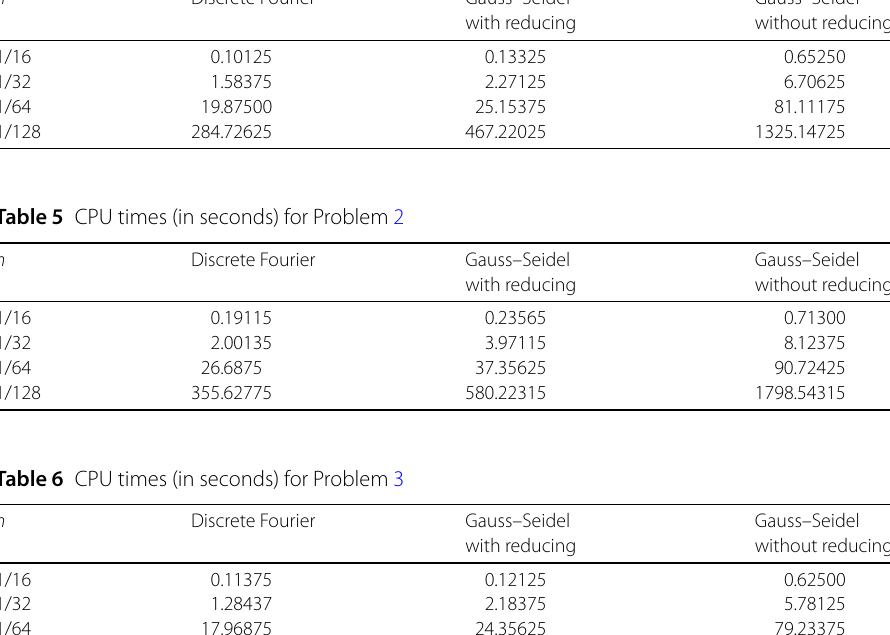
Table 4 CPU times (in seconds) for Problem 1 h